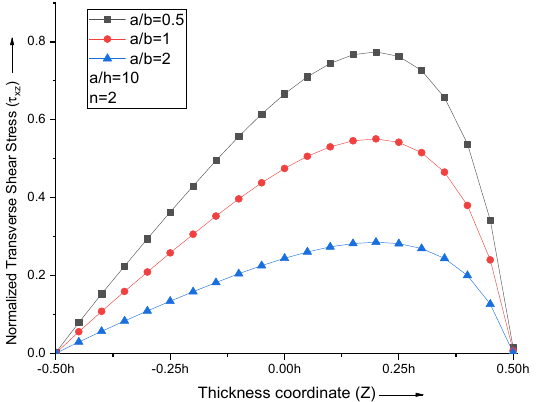
Figure 9. Effect of aspect ratio (a/b) on non − dimensional transverse shear stresses of the plate.